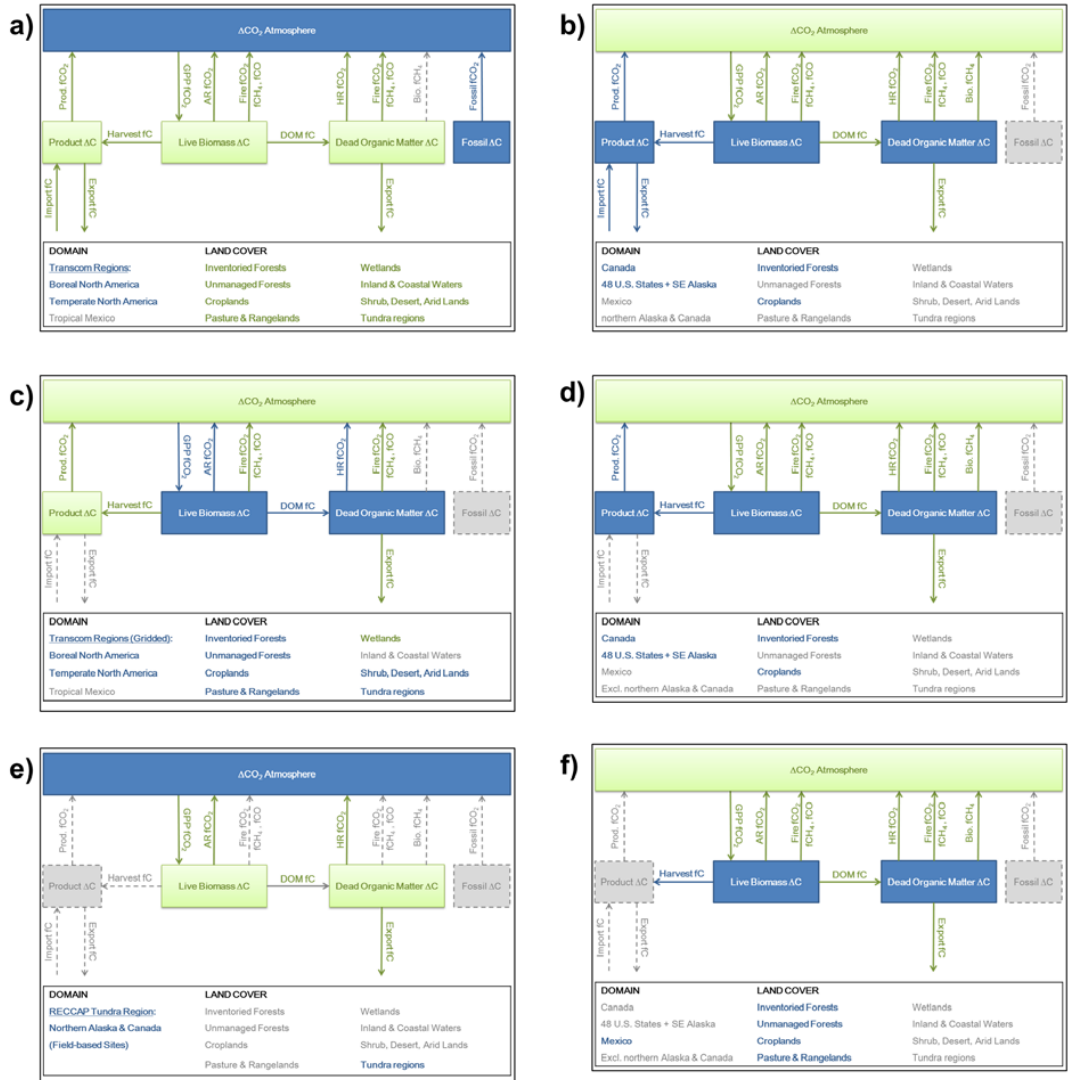
Figure 1. Carbon dioxide budget diagrams illustrating the spatial domains and component fluxes included in each approach and data set synthesized in this study: (a) atmospheric inversion models (AIMs), (b) atmospheric flow inventory, (c) terrestrial biosphere models (TBMs), (d) production approach inventory, (e) tundra ecosystem flux measurement and (f) Mexico land-use change (default approach) inventory. In each diagram, flux components are shown in blue when explicitly estimated (i.e., observed, measured or simulated), in green when implicitly contributing to an aggregated flux but not estimated directly, and in gray when explicitly not included in the estimate. Atmospheric methods (a, e) measure the concentration or flux of CO 2 in the atmosphere, which implies all land–atmosphere CO 2 exchange components (and excludes non-CO 2 fluxes). AIMs (a) integrate CO 2 concentrations for large regions (boreal and terrestrial North America) and explicitly subtract the contribution of fossil fuel emissions in order to quantify the terrestrial contribution. The eddy covariance flux measurements for the tundra region (e) are similar in concept but are site-based and so are not influenced by fire, fossil or harvested-product emissions. Inventory approaches (b, d, f) are primarily based on carbon stock change estimates in the major live biomass and dead organic-matter pools. Mostly implicit in the inventories, then, are the fluxes in and out of these pools, with the exception of harvested-carbon (crop and wood) removals that need to be tracked to determine the role of product consumption and decay emissions in the overall budget. The atmospheric flow approach (b) considers product imports and exports from international trade in calculating the stock change in the product pool, whereas the production approach (d) does not. The default approach (f) excludes the harvested-product pools from the accounting. Finally, there is large variation in how TBMs (c) explicitly simulate, implicitly include or explicitly exclude the various flux components; here, we represent a “basic case”, where all models simulate ecosystem production and respiration and track the major pools. TBMs differ widely, though, as to whether and how they simulate fire, harvest, product emission and dead organic-matter export fluxes (i.e., riverine export). None of the models in this study include estimates of fossil fuel emissions, biogenic methane flux or the lateral transfer of product carbon via international